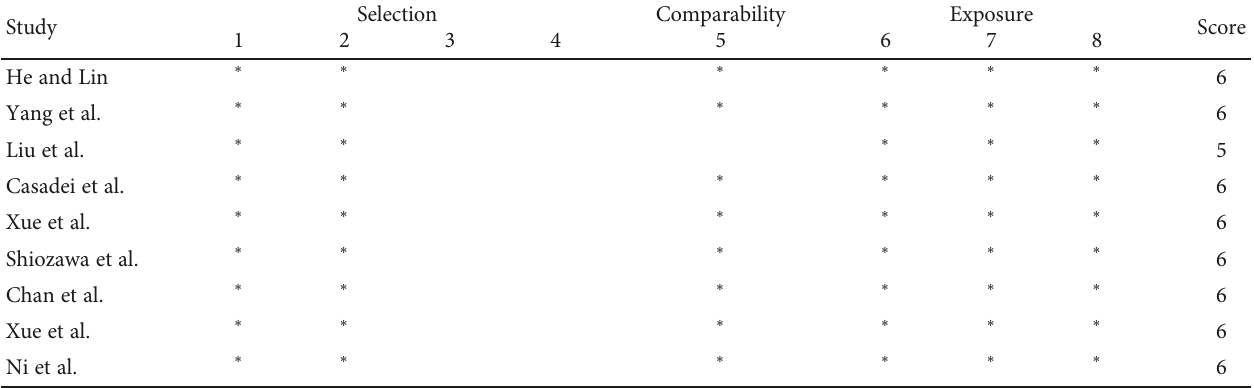
Table 2: Quality assessment and risk of bias of the included